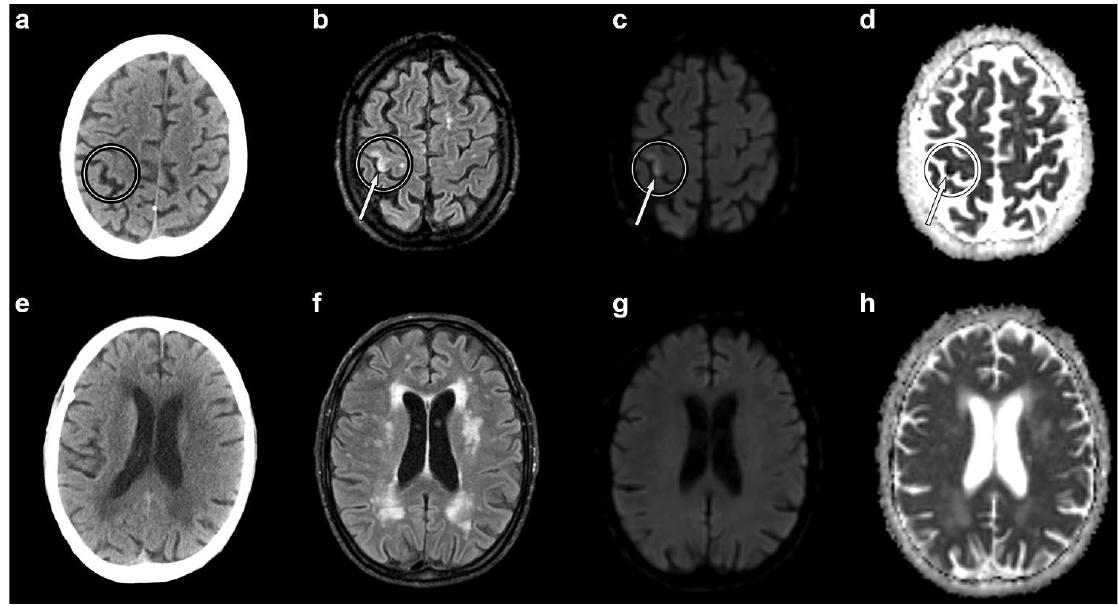
Figure 1. Non-contrast axial brain computed tomography (CT) and magnetic resonance imaging (MRI) scans. Circles indicate the right “hand - knob” area (horizontal epsilon -shaped). CT shows no evidence of cerebral air bubbles ( a ). The MRI fluid-attenuated recovery ( b ), diffusion-weighted ( c ), and apparent diffusion coefficient ( d ) sequences demonstrate a recent ischaemic lesion of the lateral portion of the right “hand - knob” area (arrows). Both CT and MRI show diffuse chronic cerebrovascular disease (lower panel: ( e – h )).